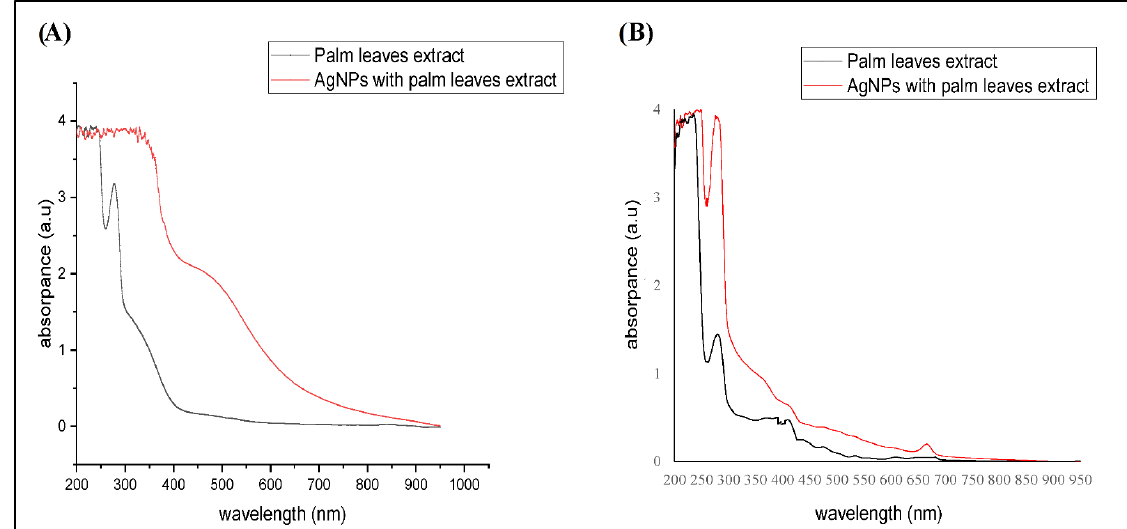
Figure 1. UV-visible spectroscopy of the studied materials. ( A ) Aqueous extract preparations of ei- ther the crude extract or biosynthesized AgNPs, ( B ) Ethanolic crude extract and biosynthesized AgNPs.